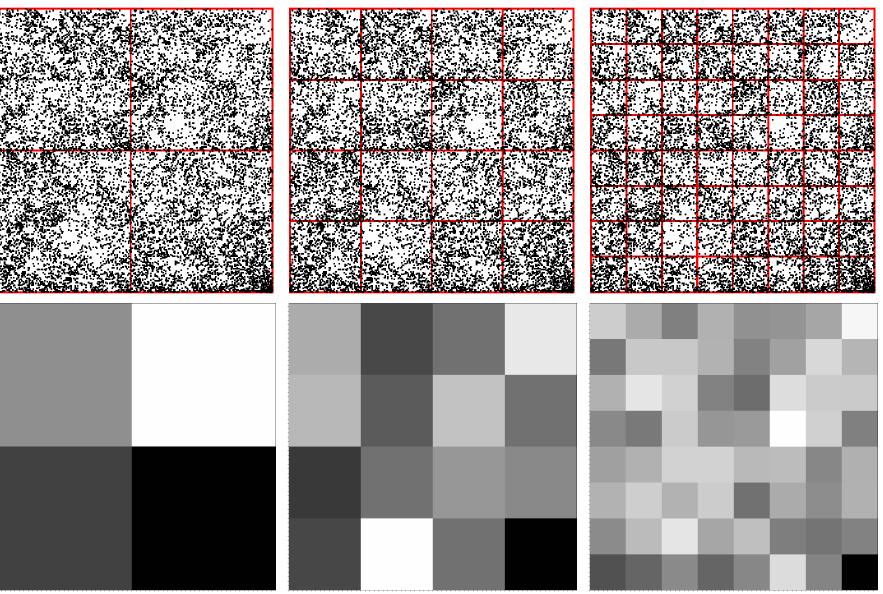
Figure 5. Two representations of E. coli in the “ATGC” system. ( Upper row ) CGR, where the positions of the nucleotides are in orange. On top of each image is superimposed a grid of different sizes: 2 × 2 ( left ), 4 × 4 ( middle ) and 8 × 8 ( right ) cells. ( Lower row ) FCGR for monomers ( left ), 2-mers ( middle ) and 3-mers ( right